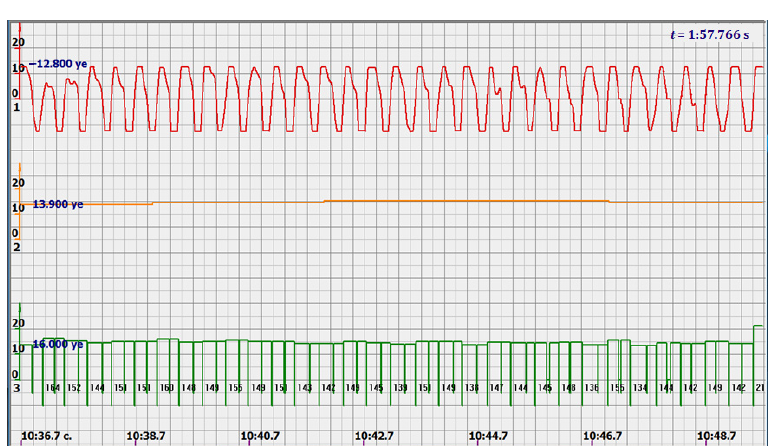
Figure 19. Heart rate: from 141 to 169 bpm.